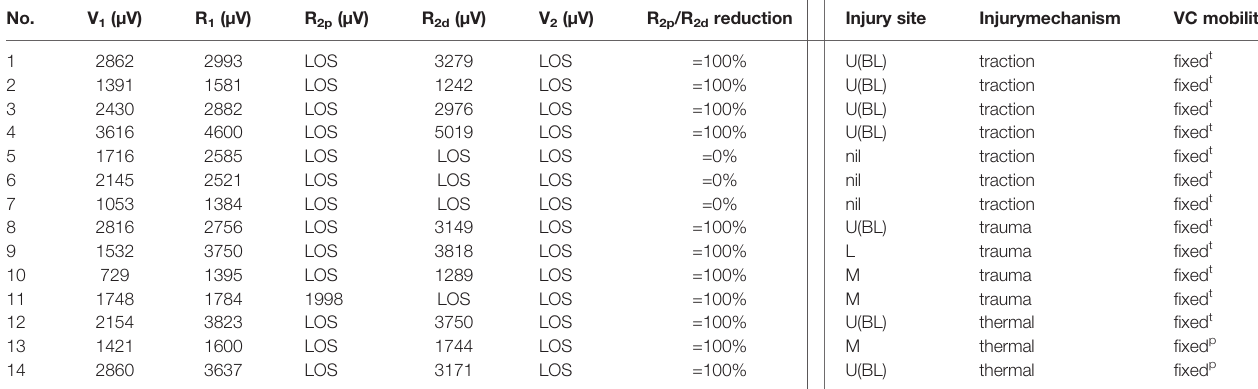
TABLE 4 | Intraoperative EMG signals and mechanism of nerve injury in the RLNs with complete LOS. No.